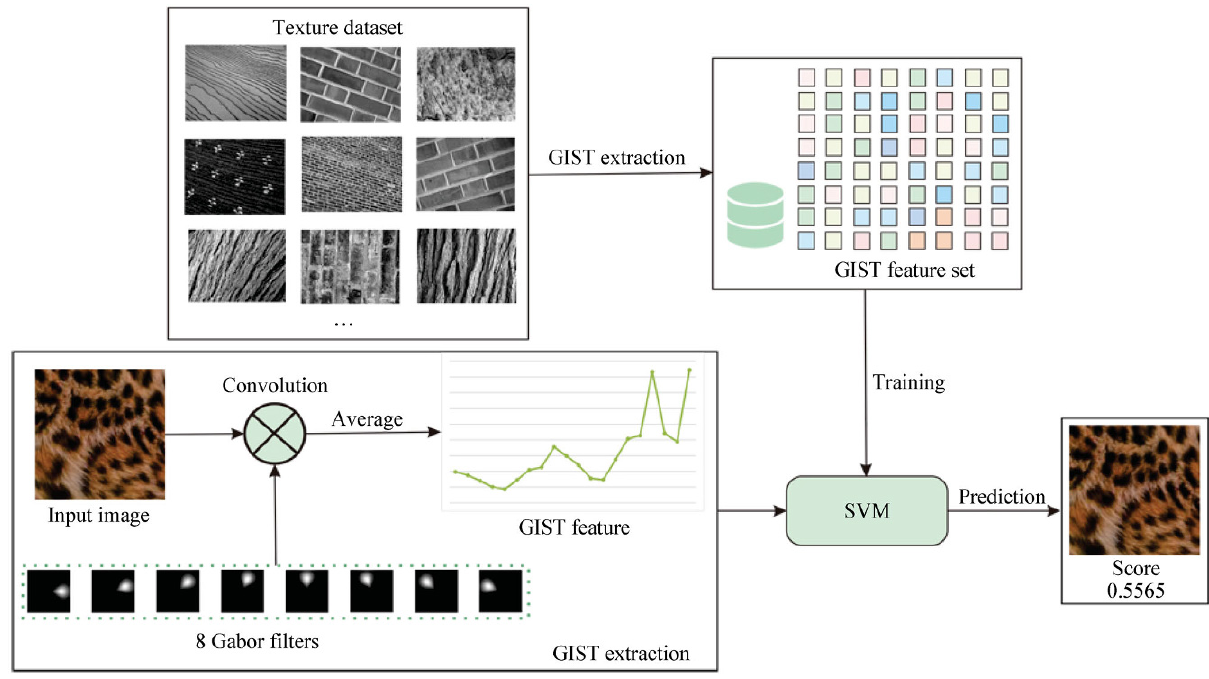
Fig. 3 Global textureness